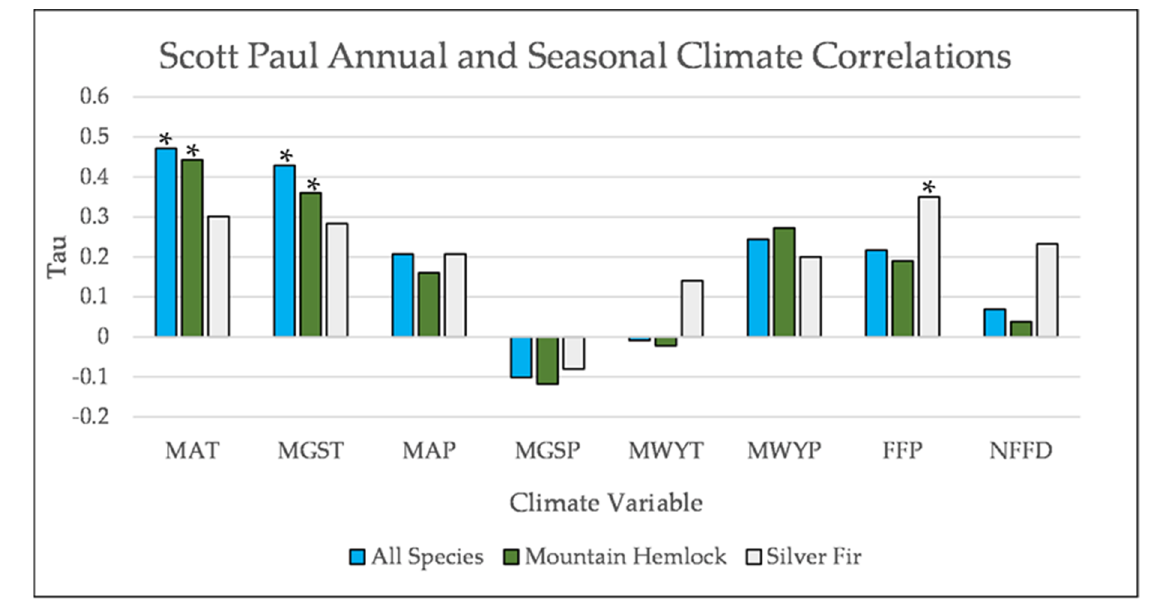
Figure A8. Partial Kendall’s correlations between establishment and annual and seasonal climate variables at Scott Paul. * = p -value < 0.05. Mean Annual Temperature (MAT), Mean Growing Season Temperature (MGST), Mean Annual Precipitation (MAP), Mean Growing Season Precipitation (MGSP), Mean Water Year Temperature (MWYT), Mean Water Year Precipitation (MWYP), Frost Free Period (FFP), and Number of Frost-Free Days (NFFD).